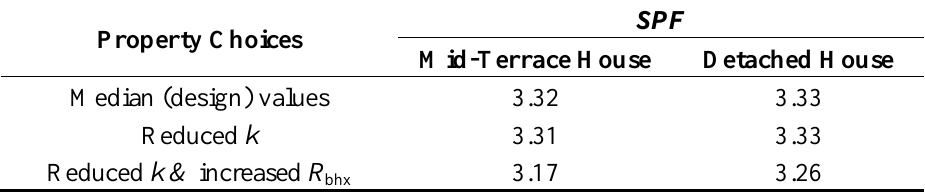
Table 4. Sensitivity to variations in soil conductivity and borehole resistance.